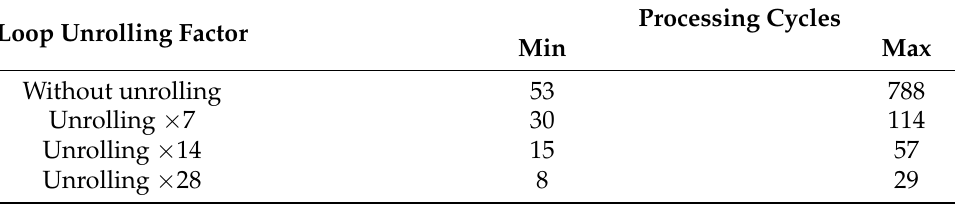
Table 4. Processing time on expansion/projection FU with different loop unrolling